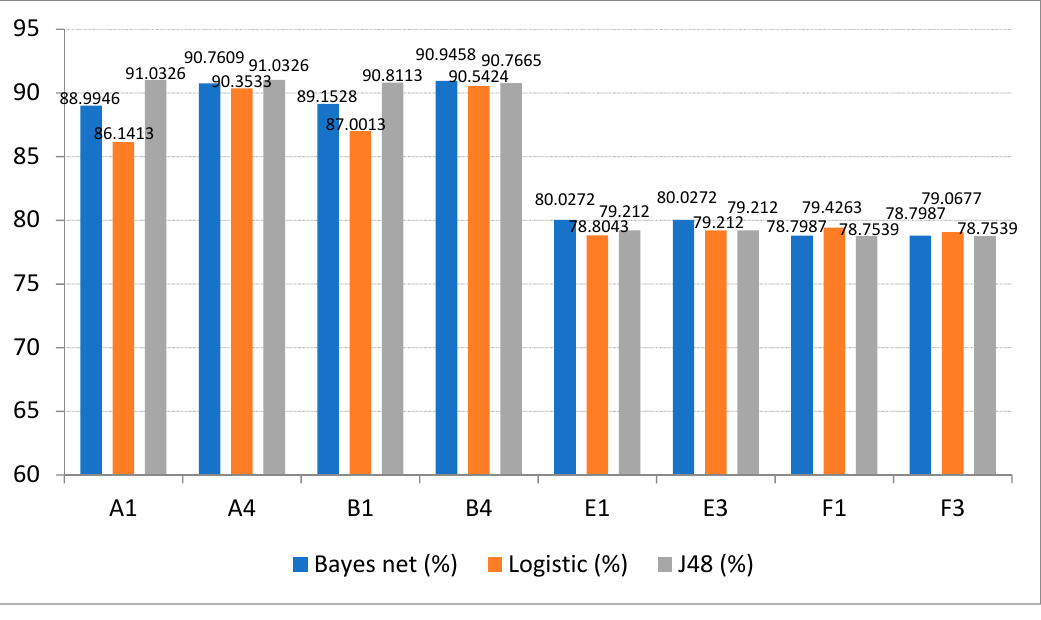
Figure 11. Bar graph with a net profit as decision attribute. Table 9. Statistical table with NSS as decision attribute.